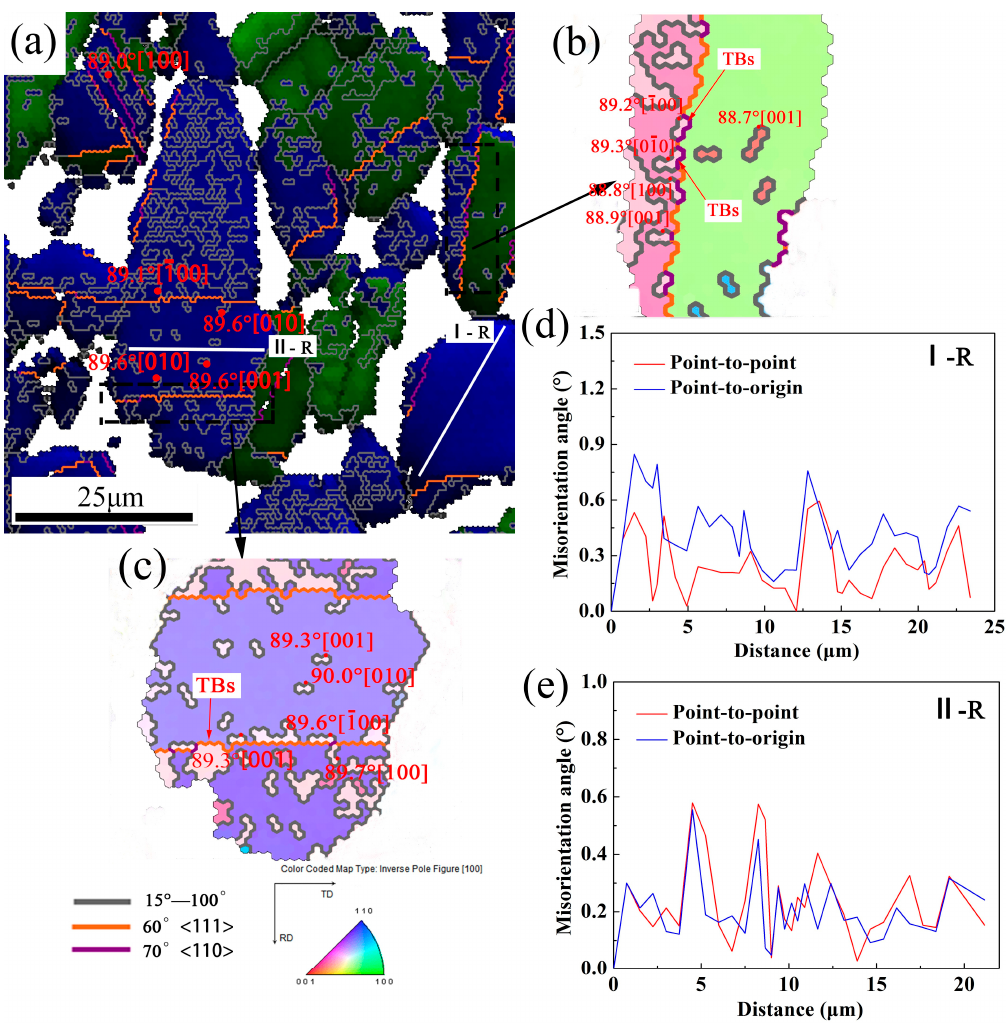
Figure 8. ( a ) A magnified view of the region 2 (see Figure 7) with HAGBs (HAGBs: gray lines; twin boundaries: orange and purple lines); ( b , c ) The inverse pole figures corresponding to a single deformed grain and a recrystallized grain, respectively (twin boundaries: TBs); ( d , e ) Misorientation measured along the lines denoted as I-R and II-R in the recrystallized grains (recrystallized grain “R”).